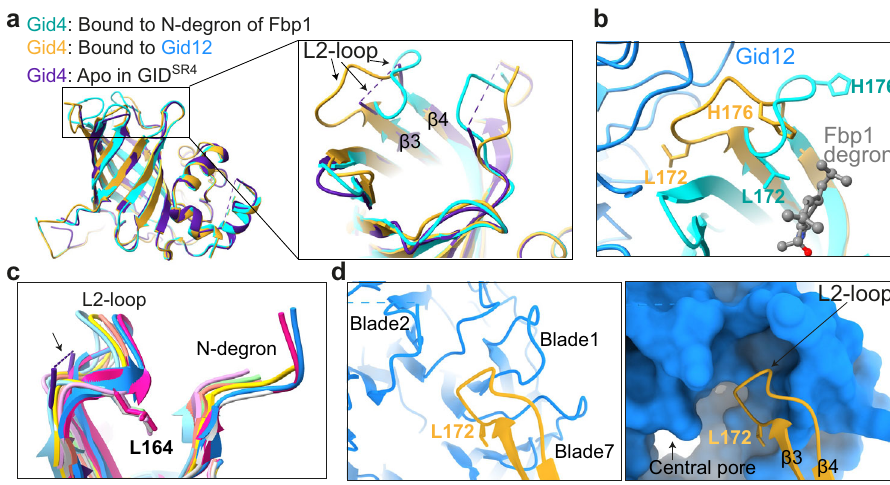
Fig. 3 Gid12 remodels the N-degron binding pocket in Gid4. a Superposition of Gid12-bound Gid4 (gold) with prior structures of Gid4 from GID SR4 complexes without substrate ( “ Apo ” , PDB ID: 6SWY, purple) and bound to the Pro/N-degron of Fbp1 (PDB ID: 7NS3, cyan) reveals conformational heterogeneity of Gid4 L2-loop. b Closeup showing structural differences in Gid4 L2-loop when bound to Gid12 (Gid4 in gold) or to Pro/N-degron of Fbp1 substrate (Gid4 in cyan, PDB ID: 7NS3). c L2-loop structural similarity amongst human Gid4 structures with various N-degron peptides (PDB ID: 6CCT, 6CCU, 6CD8, 6CD9, 6CDC, 6CDG, 6WZX, 6WZZ; colored in cyan, pink, lawn green, salmon, gray, yellow, deep pink and blue respectively). Yeast Gid4 from apo GID SR4 (6SWY) is shown in purple with its disordered L2-loop indicated with arrow and dotted line, and human Gid4 Leu164, which corresponds to yeast Gid4 Leu172, are shown for reference. d Closeups showing Gid4 L2-loop (gold) bound to Gid12 (blue), with Gid12 depicted as ribbon (left) or surface (right). The Gid4 L2-loop conformation complements the Gid12 pocket at the junction between blades 7 and 1 in the central pore.